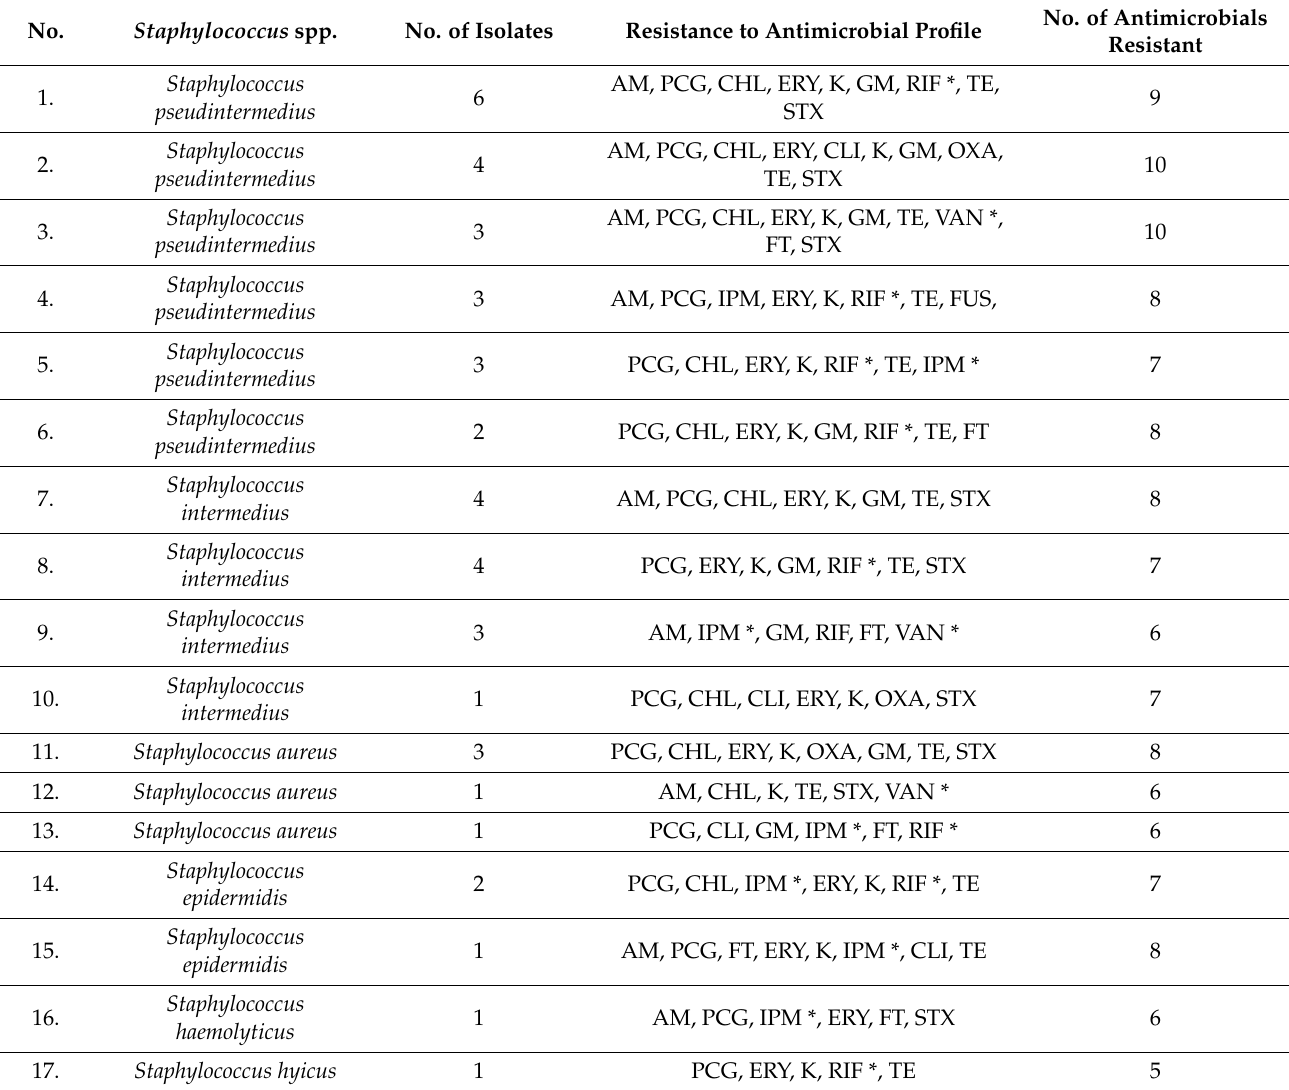
Table 4. Patterns of resistance in Staphylococcus spp. ( n = 43), obtained from stray dogs with skin lesions, exhibiting resistance for more than three